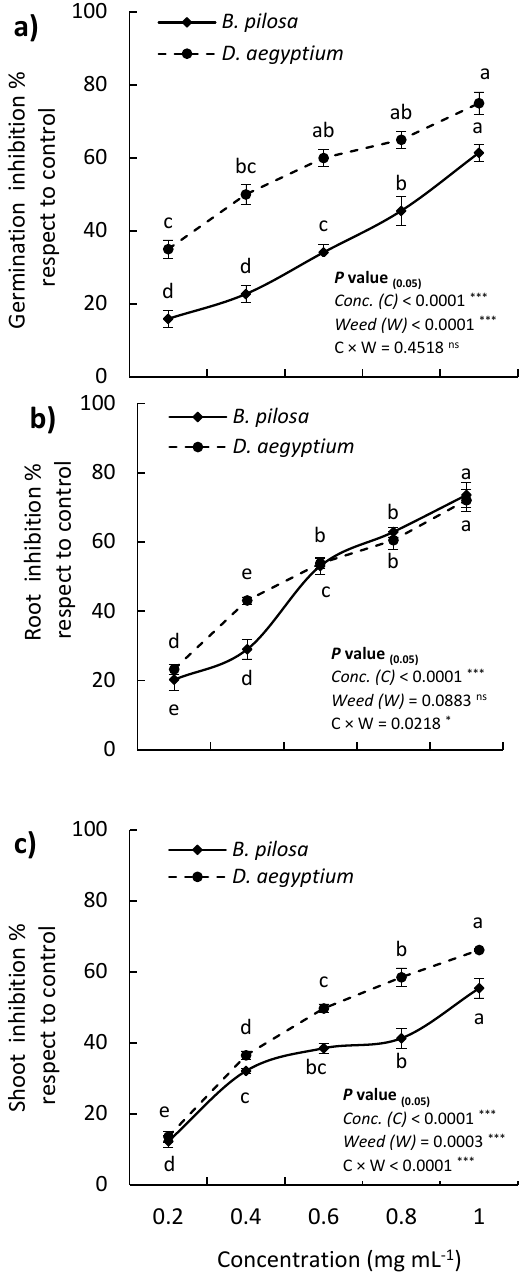
Figure 3. Allelopathic e ff ect of the essential oil from the above-ground parts of Pulicaria somalensis (Shie) on ( a ) seed germination, ( b ) root growth, and ( c ) shoot growth of Dactyloctenium aegyptium (crowfoot grass) and Bidens pilosa (hairy beggarticks). Within each line, di ff erent letters indicate statistically significant di ff erences at p ≤ 0.05. ns: non -significant.